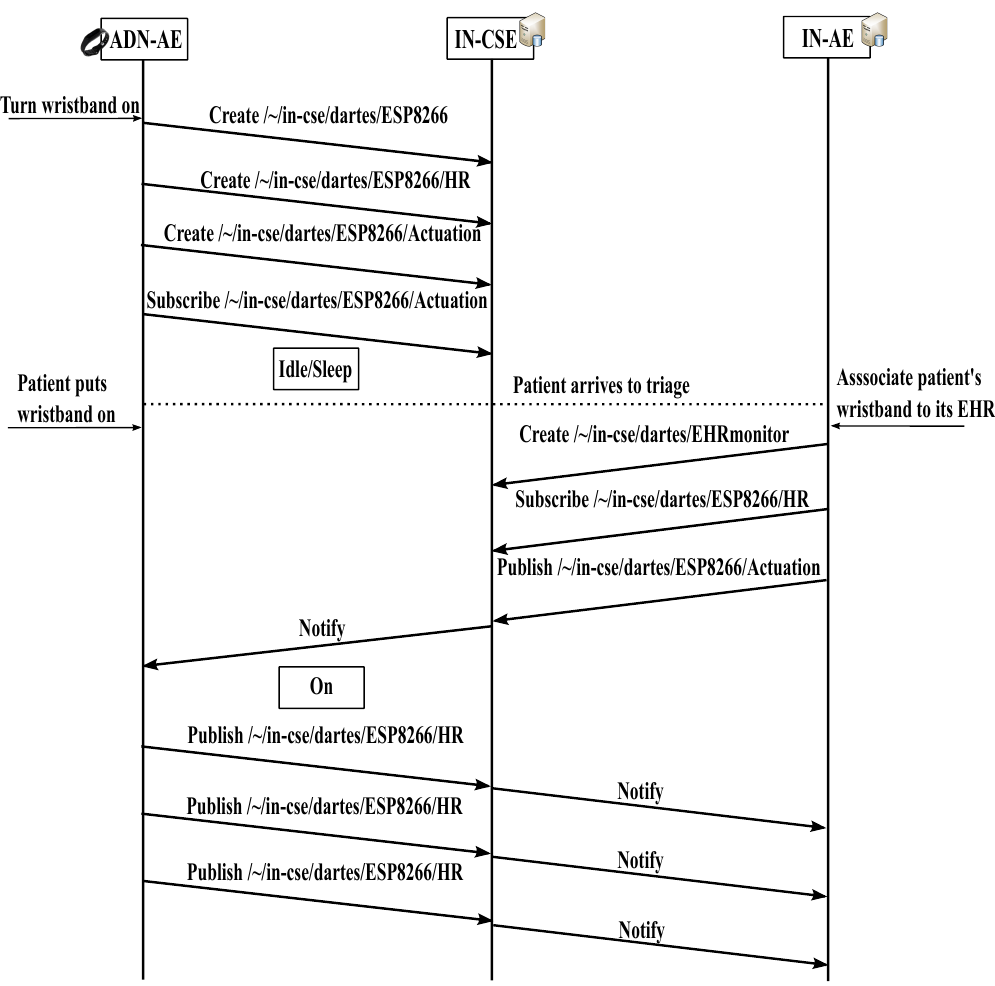
Figure 3. Messages exchanged from the moment the wristband is turned on until the wristband is assigned to a patient and starts publishing